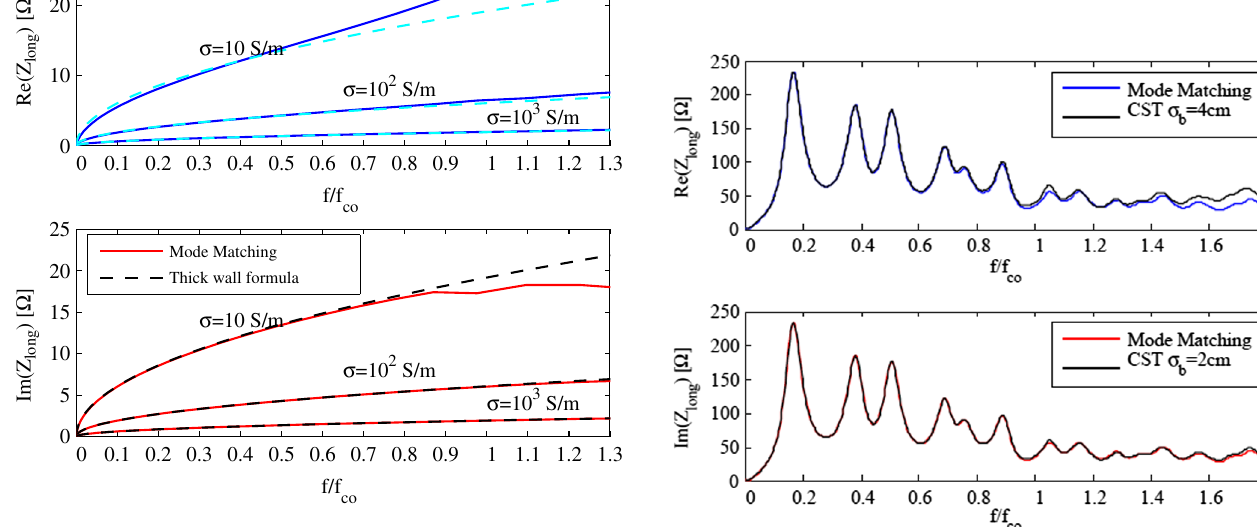
FIG. 6 (color online). Comparison with CST simulations. CST ¼ 4 cm: 1 M mesh cells, 20 m wake; for parameters σ b σ ¼ 2 cm: 7 M mesh cells, 20 m wake. Mode matching . Mode b co parameters: S ¼ 10 , P ¼ 10